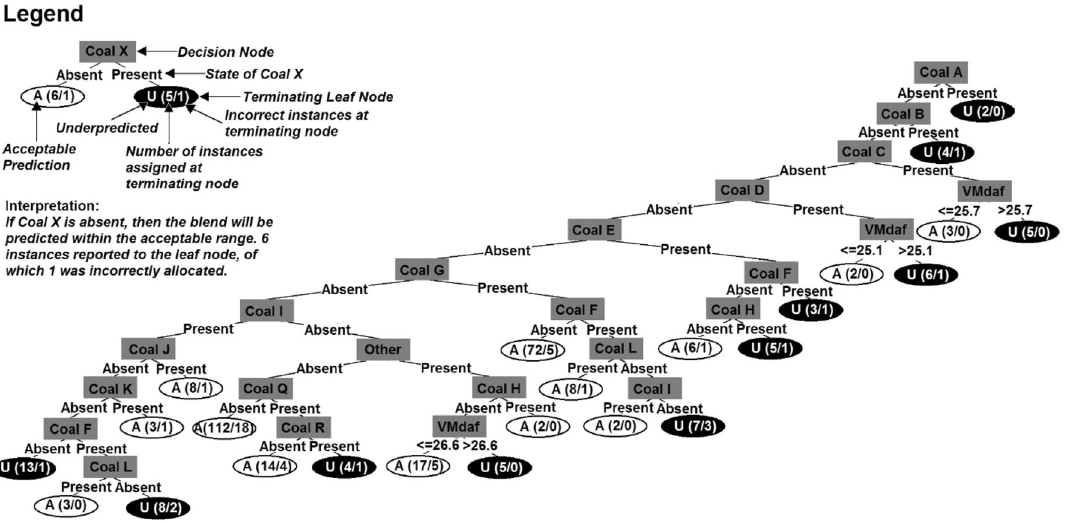
Fig. 9 J48 decision tree for underpredicted blends from the original model. Boxes indicate a decision point, whilst ovals are terminal nodes. A white node with black text represents a sample predicted by the original regression model within the RMSE, whilst a black node with white text represents a sample that is underpredicted by the original